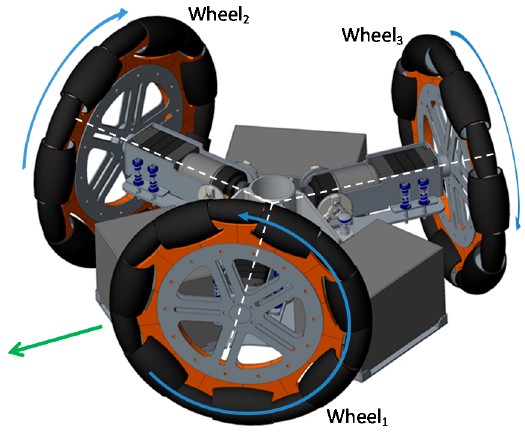
1 is the front-left, wheel 2 is the front-right, and wheel 3 is the back wheel.